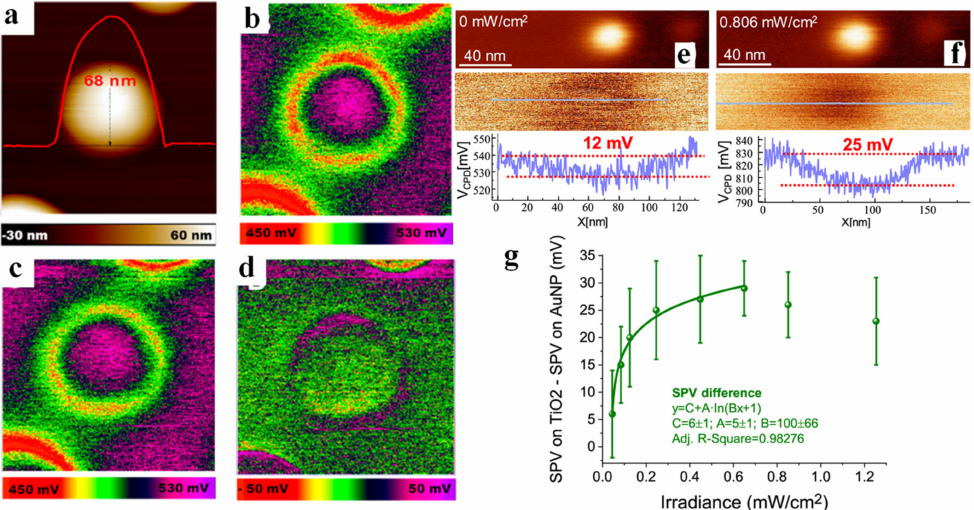
Figure 4. AFM topography image of Au NP deposited on a TiO 2 rutile single crystal. The height of a single Au NP is about 68 nm ( a ). KPFM images of Au/TiO 2 : in the dark ( b ) and upon 532 nm illumination ( c ). SPV image by subtracting the potential under dark conditions from that under 532 nm illumination ( d ) (SPV, ∆ CPD = CPD light − CPD dark ). Adapted with permission from ref. [85]. Copyright 2017 American Chemical Society. Topography (top) and V CPD (bottom) images of a 3 nm diameter Au NP on bare TiO 2 (110) ( e ) in the dark and ( f ) under UV illumination. V CPD profiles are shown at the bottom. Color scale in topography: ( e ) 3.6 nm and ( f ) 4 nm. Difference between SPV on bare TiO 2 and SPV on the Au NP as a function of irradiance ( g ). Adapted with permission from ref. [86]. Copyright 2021 American Chemical Society.